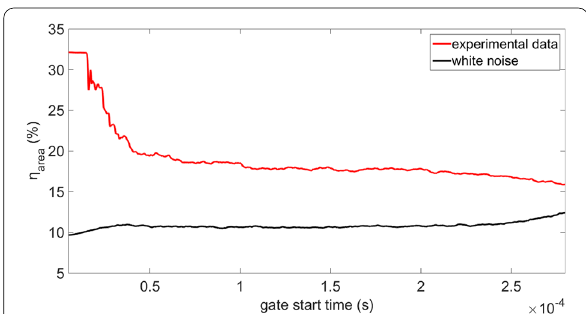
Figure 11 Diffuse field verification on white noise and experimental data using metric η area